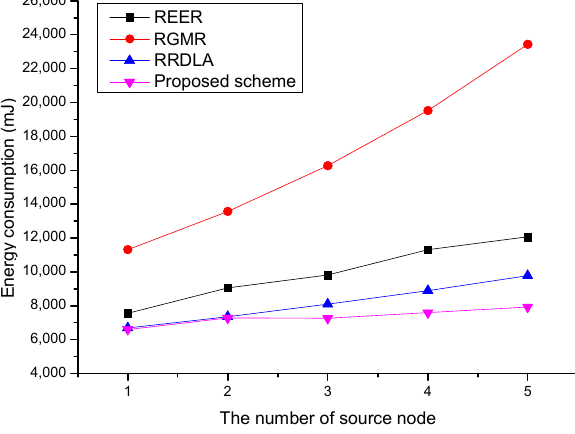
Figure 11. Average energy consumption vs. the number of source nodes with 90% of the link